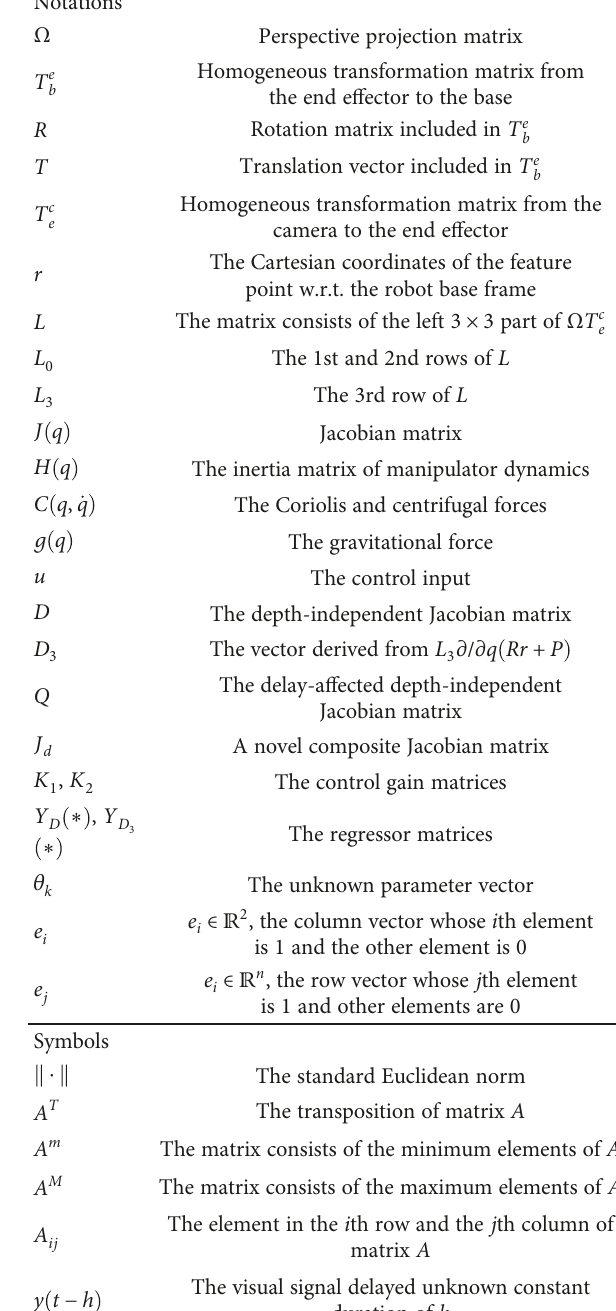
Table 2: List of notations and